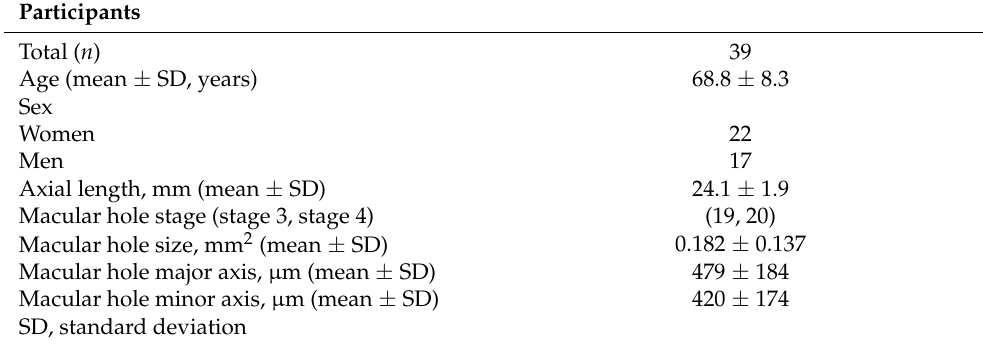
Table 1. Participants’ baseline characteristics.